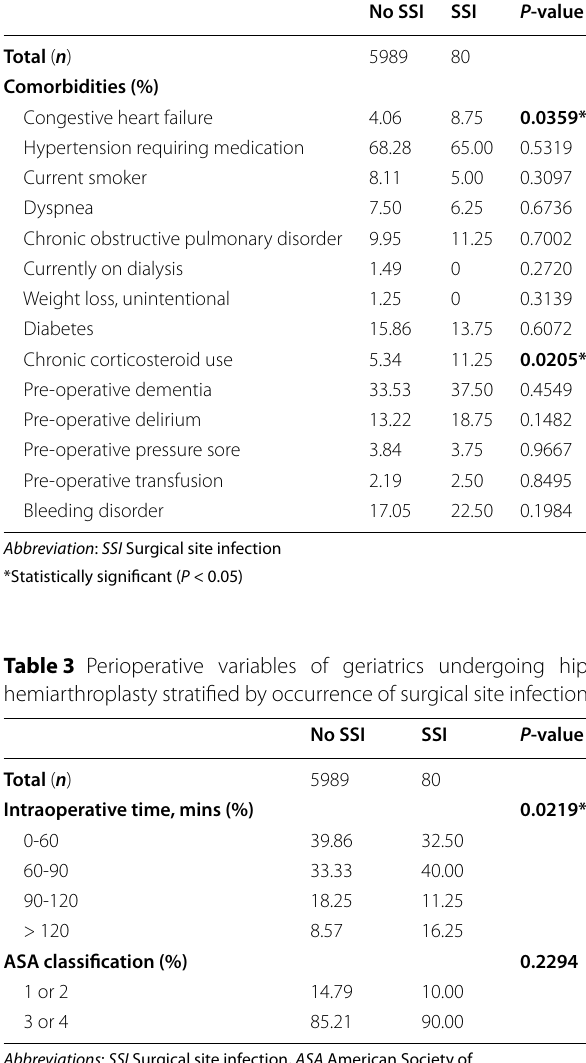
Abbreviations : SSI Surgical site infection, ASA American Society of Anesthesiologists *Statistically significant ( P < 0.05)